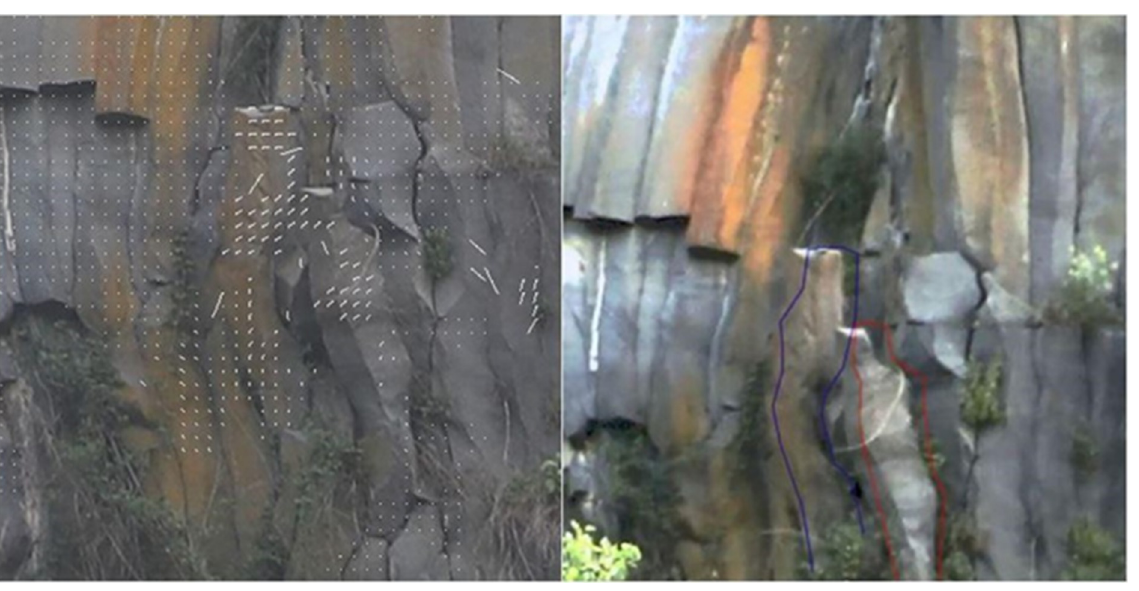
Figure 8. Left , movement vectors from camera 2. Right , in red and blue the original position of the columns.